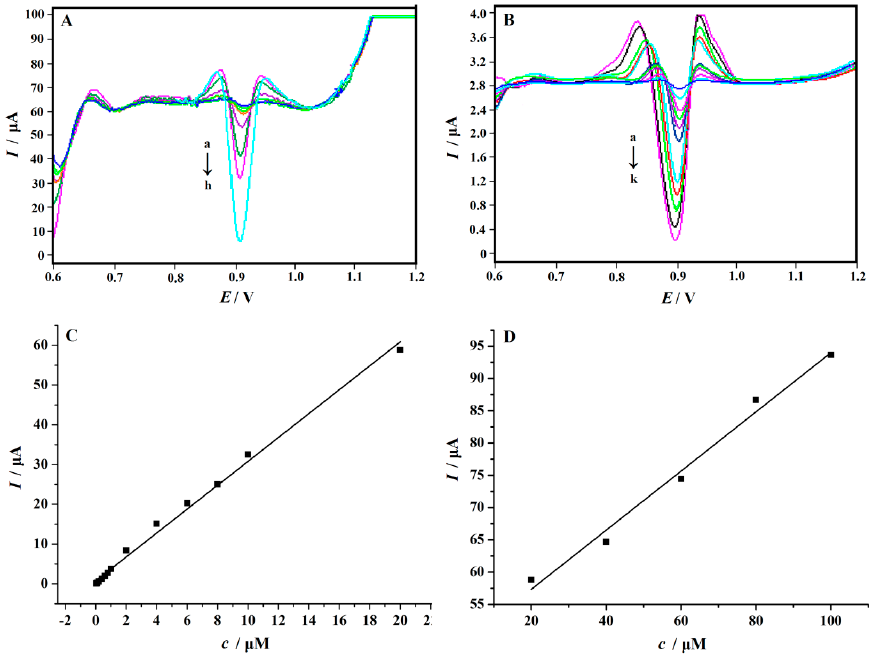
Figure 9. SDLSVs of different concentration of vanillin in 0.1 M HCl solution recorded at the CeO 2 /ERGO/GCE after accumulation at 0.1 V for 120 s at a scan rate of 0.1 V s − 1 . ( A ) a-h: 0.04, 0.06, 0.08, 0.1, 0.2, 0.4, 0.6, 0.8 µM; ( B ) a-k: 1, 2, 4, 6, 8, 10, 20, 40, 60, 80, 100 µM. ( C ) Calibration curve ( C vanillin = 0.04–20 µM) and ( D ) Calibration curve ( C vanillin = 20–100 µM).